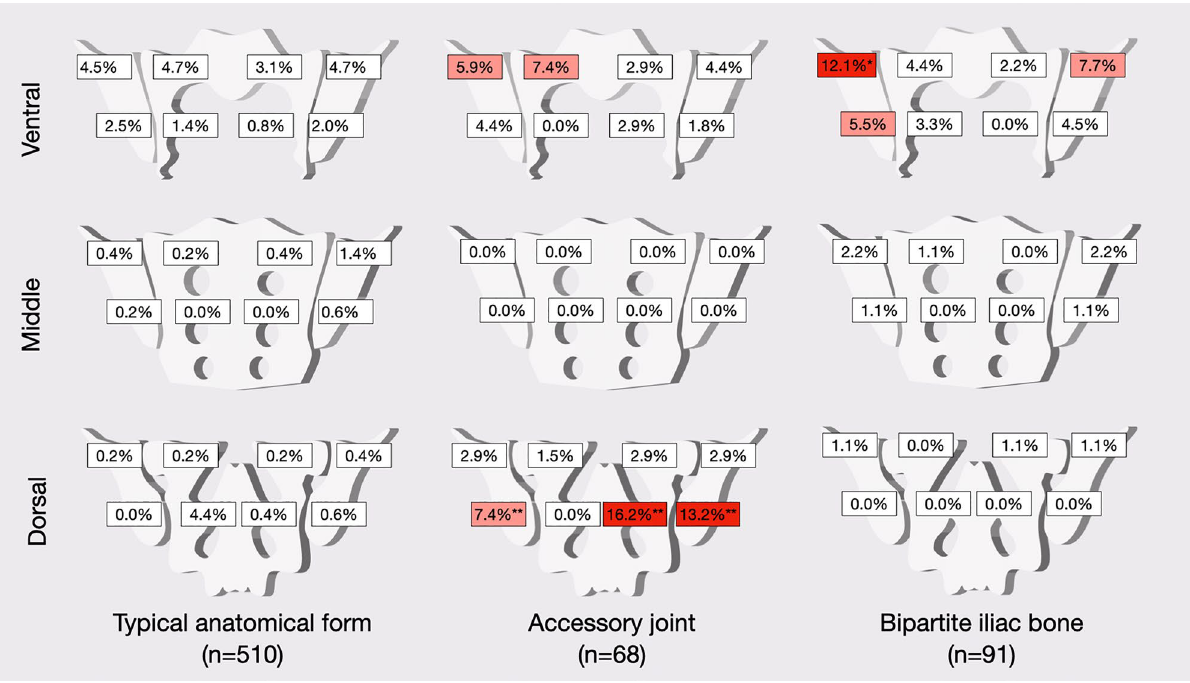
Figure 3. Frequency of sclerosis per region for different anatomical forms (%) . Upper row: ventral portion of the joint (regions 1–8). Middle row: middle portion of the joint (regions 9–16). Lower row: dorsal portion of the joint (regions 17–24). Columns represent anatomical types. Frequencies smaller than 5% are given in white boxes, frequencies of 5 to 10% are given in light red, frequencies above 10% are given in dark red boxes. Significantly higher frequencies (compared to both other groups using Chi-squared tests) are marked with asterisks: *p < 0.05/**p <